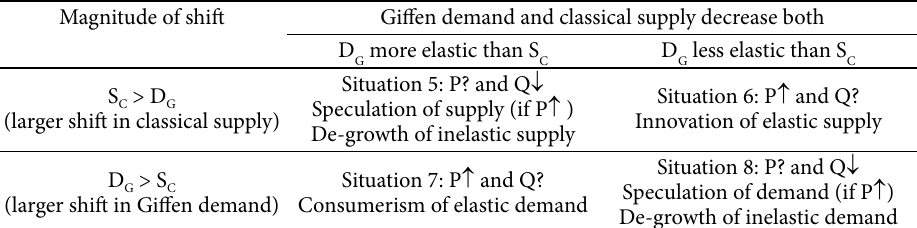
D less elastic than S C G C Situation 6: P ↑ and Q?